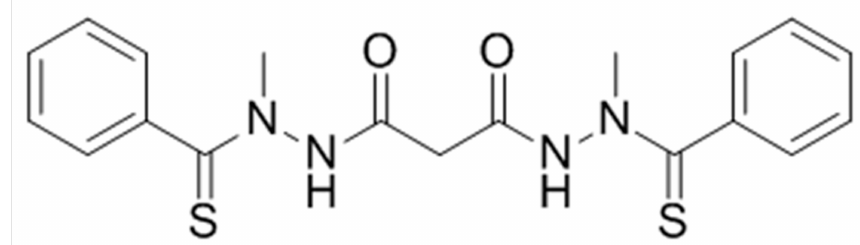
Figure 1. Chemical structure of elesclomol (MedChemExpress, https: // www.medchemexpress.com /